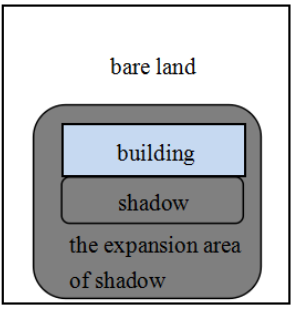
Figure 12. A diagram of the method for distinguishing bare land and buildings